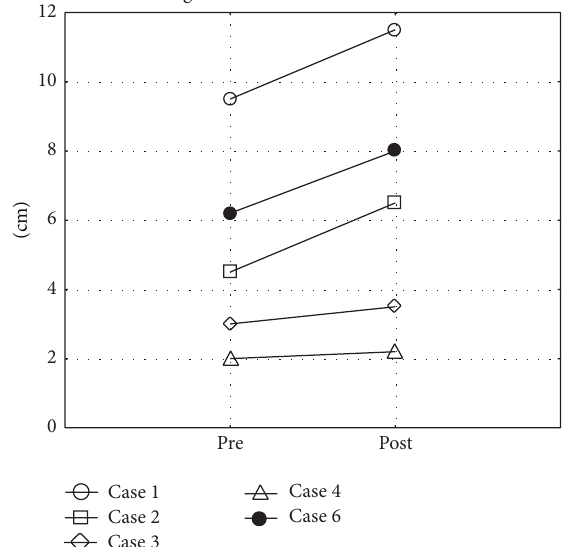
Figure 2: Difference in thoracic range of motion between maximal inhalation and exhalation at the level of the fourth costae before (pre) and after (post) 12 weeks of Glossopharyngeal Insufflation (missing data on 1